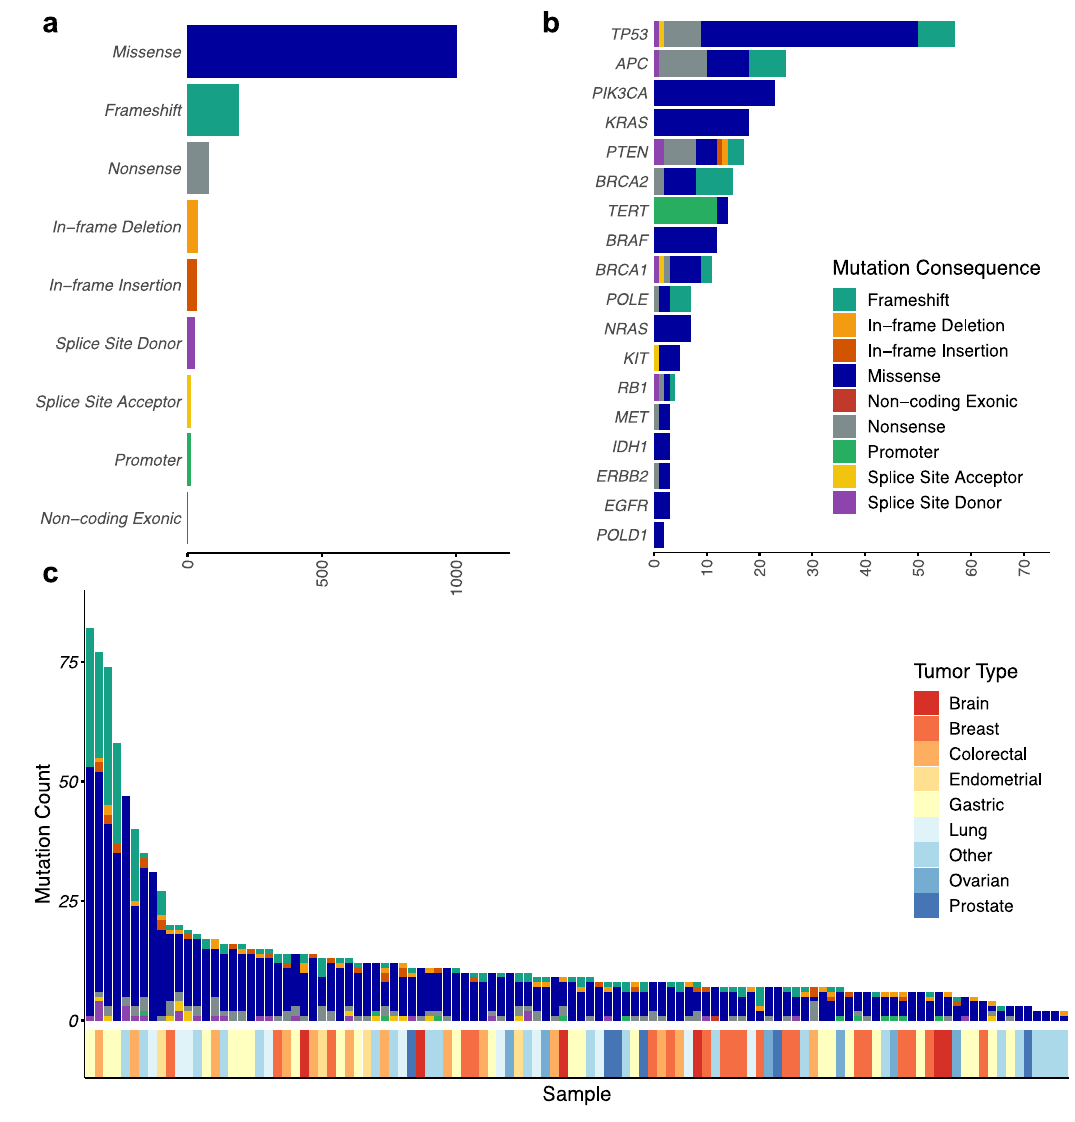
Fig. 2 Genomic landscape of sequence variants identi fi ed by elio tissue complete. Distribution of variant consequences identi fi ed among genes included in elio tissue complete across 112 FFPE tumor specimens analyzed ( a ), with speci fi c alterations in select driver genes highlighted in ( b ). c The landscape of mutations identi fi ed, by consequence, per sample demonstrated a wide dynamic range in the number and type of variants identi fi ed across the cohort, with the tumor types indicated below each case. Two cases, in which no alterations were identi fi ed, are not displayed. Source data are provided as a Source Data fi